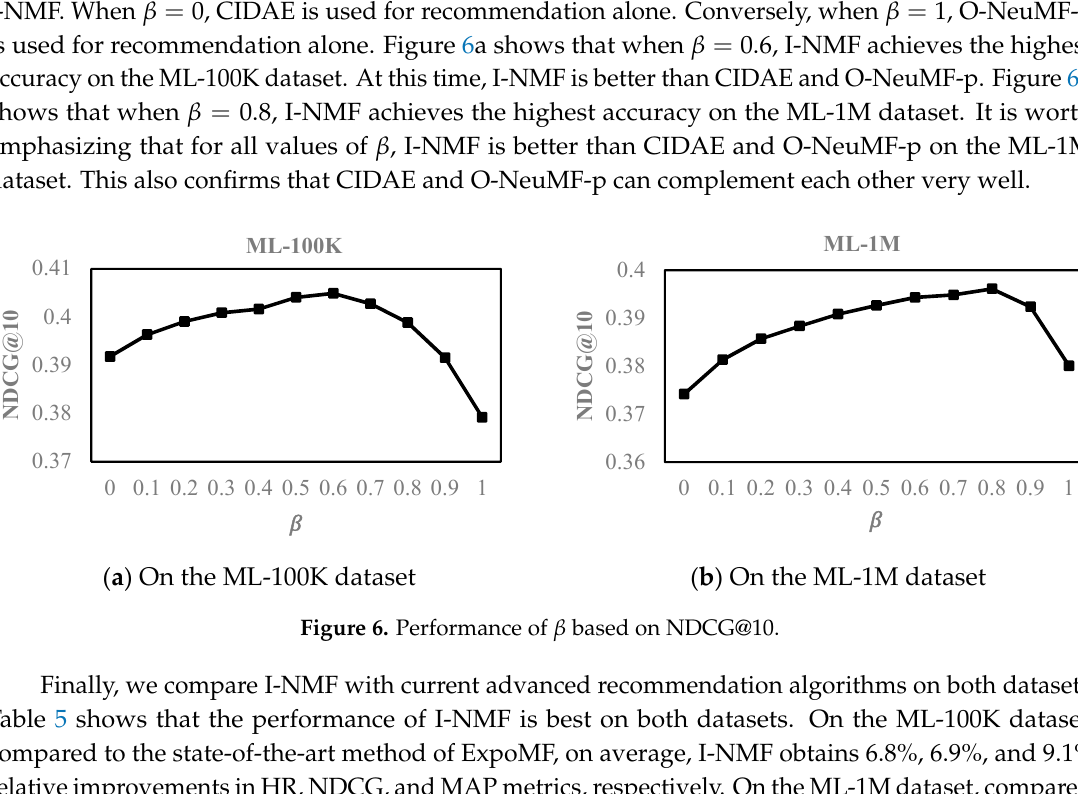
Table 5. Performance comparison of I-NMF and advanced recommendation algorithms based on